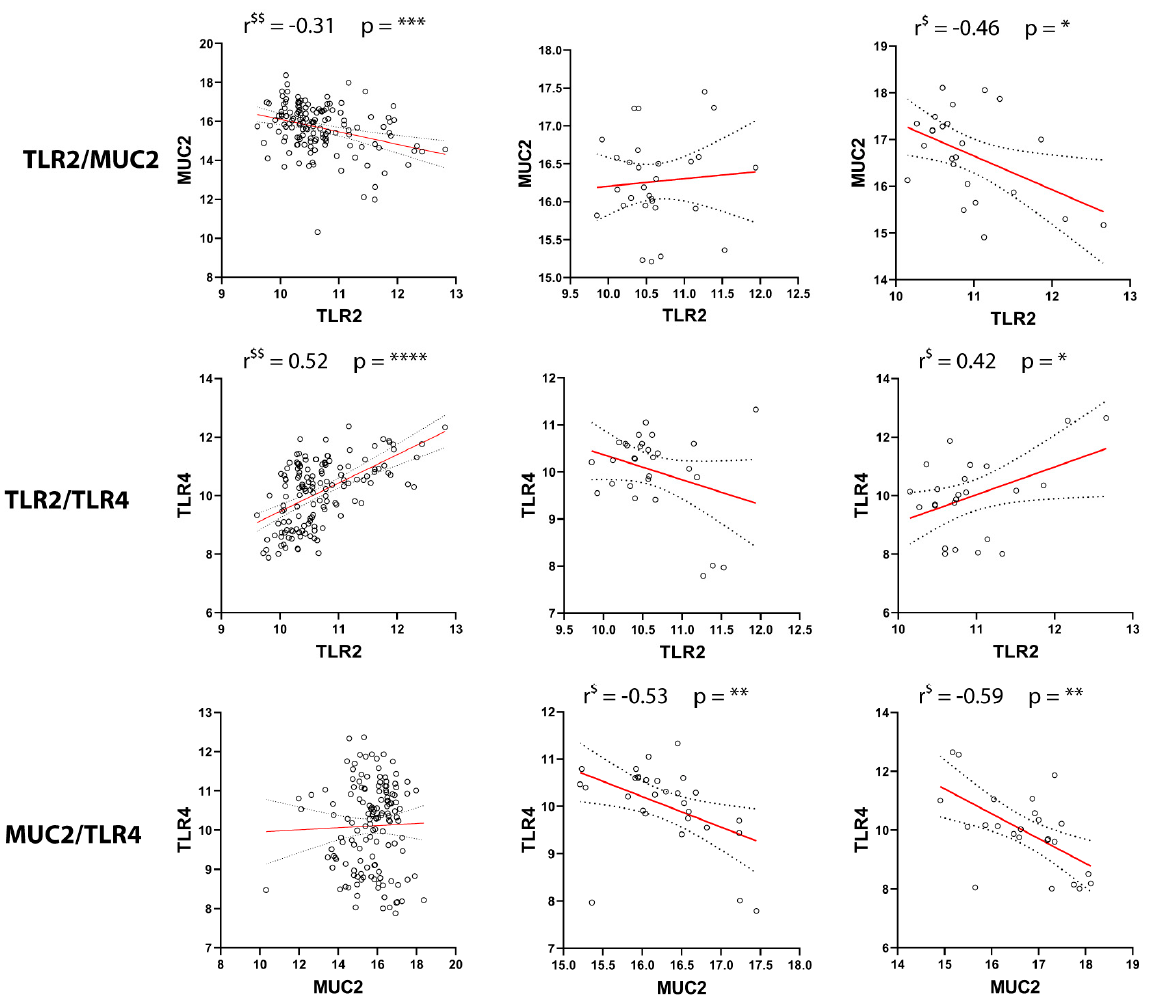
Figure 6. Pairwise correlations between GILZ , MUC2 , TLR2 , and TLR4 in healthy and CD tissues. Correlations between the expressions of the four genes in healthy control tissue ( left panels), non-inflamed tissue ( middle panels), and inflamed tissues ( right panels) from CD patients are shown. $: significant according to Pearson’s correlation analysis; $$: significant according to Spearman’s correlation analysis. p -values < 0.05 were considered statistically significant; p < 0.05 = *; p < 0.01 = **; p < 0.001 = ***; p < 0.0001 = ****. Non-significant correlations ( p > 0.05) were not reported.